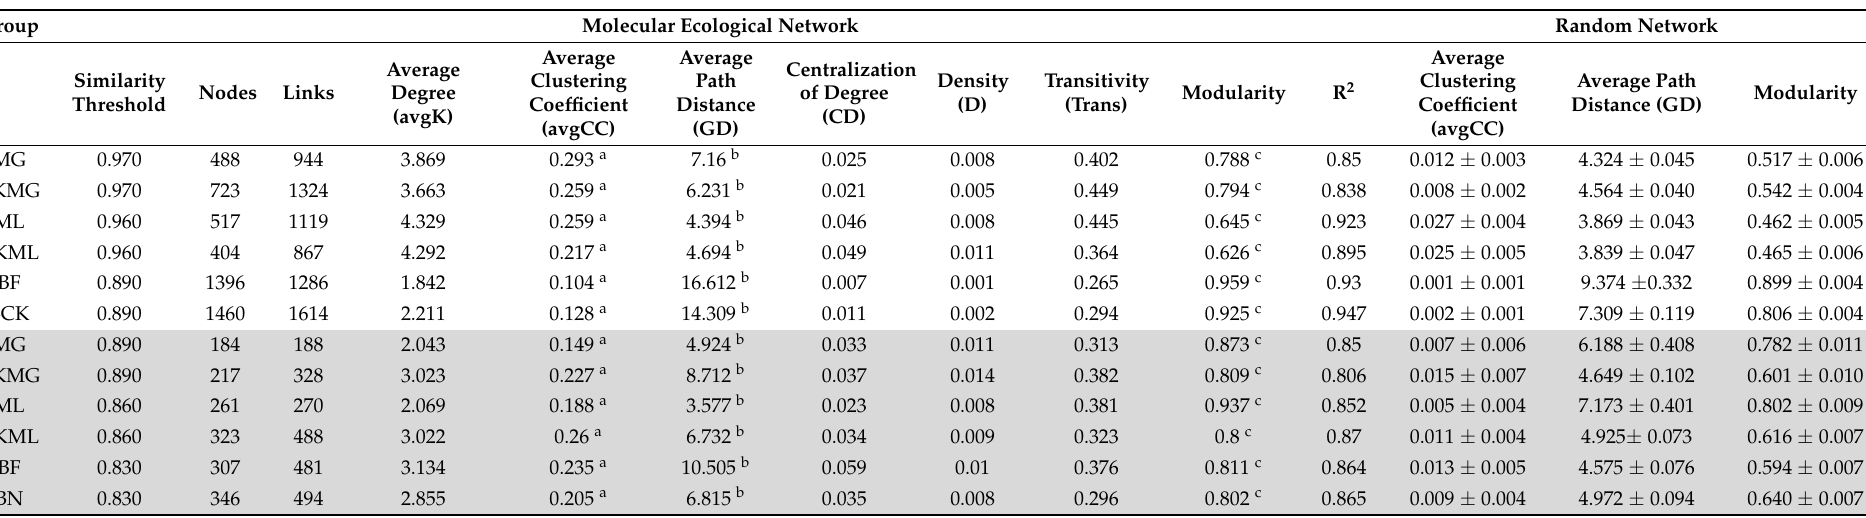
Table 2. Properties of empirical and randomized molecular ecology networks (MENs) for prokaryotic and fungal communities under OF and non-OF treatments. Randomized networks were performed by rewiring all the nodes and links corresponding to empirical networks 100